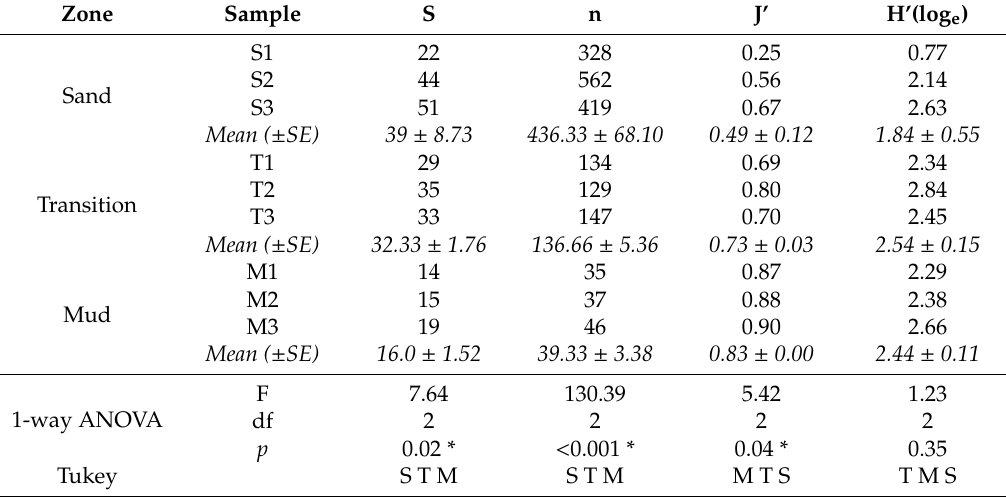
Table A3. Macrofaunal community descriptors obtained for the three sampled zones and results for one-way ANOVA and post-hoc Tukey testing for di ff erences among sediment zones. Numbers 1 to 3 are replicates. S = sand zone; T = transition zone; M = mud zone; S = species richness; n = total number of individuals; J’ = Pielou evenness index; H’ (log e) = Shannon diversity index. Mean and standard error (SE) are included for each descriptor in each zone. Asterisk (*) indicates significant p -values ( p < 0.05). For Tukey pairwise tests, zones (S, T and M) linked with the same line are not statistically di ff erent.